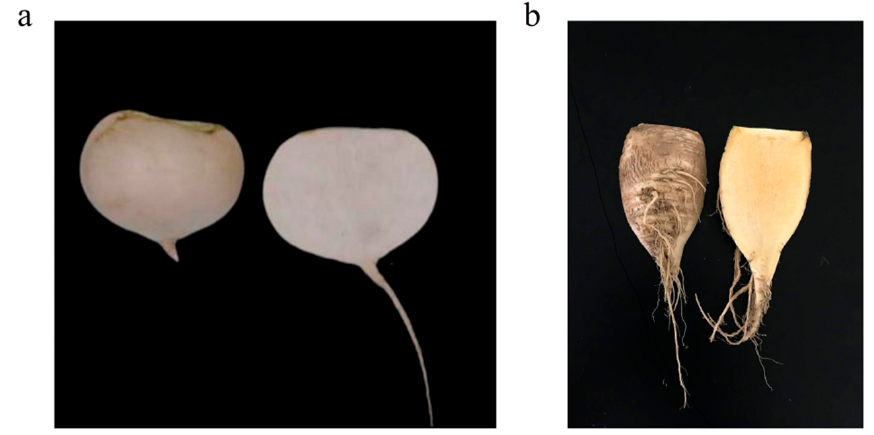
Figure 1. The phenotypes of the turnips at 70 days after planting. ( a ) W21. ( b ) W25. The size and distribution of transcripts and unigene length analysis showed that 133,252 (44.58%) transcripts were less than 500 bp in length and 26,755 (8.95%) transcripts were more than 2000 bp in length, 88,523 (34.89%) unigenes were less than 500 bp in length and 26,755 (10.55%) unigenes were more than 2000 bp in length (Figure S1a, Table S3). Coding sequence (CDS) length and predicted protein sequence were also analyzed. A